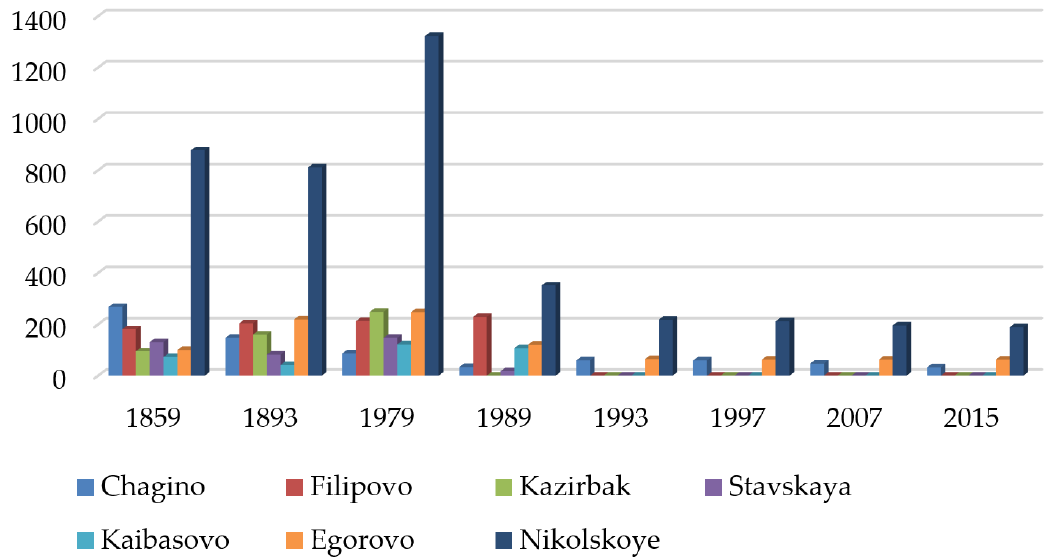
Figure 6. Population dynamics of villages in study area.